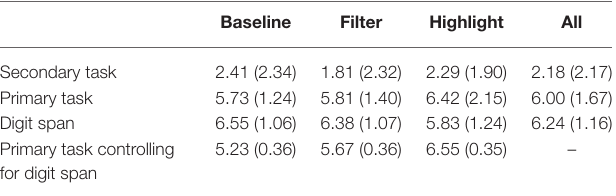
TABLE 5 | Experiment 2, Mean (StD) in secondary task of number of words remembered correctly in the serial recall task out of maximum 8, in primary task of plan questions answered correctly out of maximum 10, digit span performance, and estimated marginal means (StD) for primary task of plan questions answered correctly out of maximum 10 with covariate digit span evaluated at